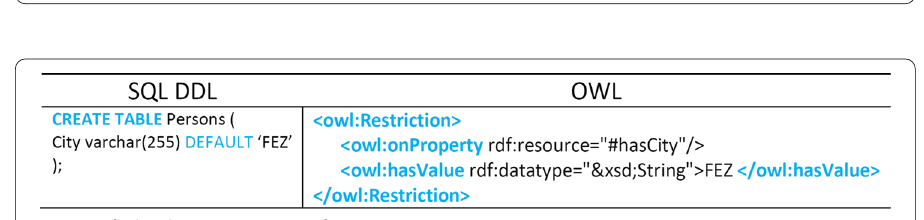
Fig. 3 Check constraint for data range restriction